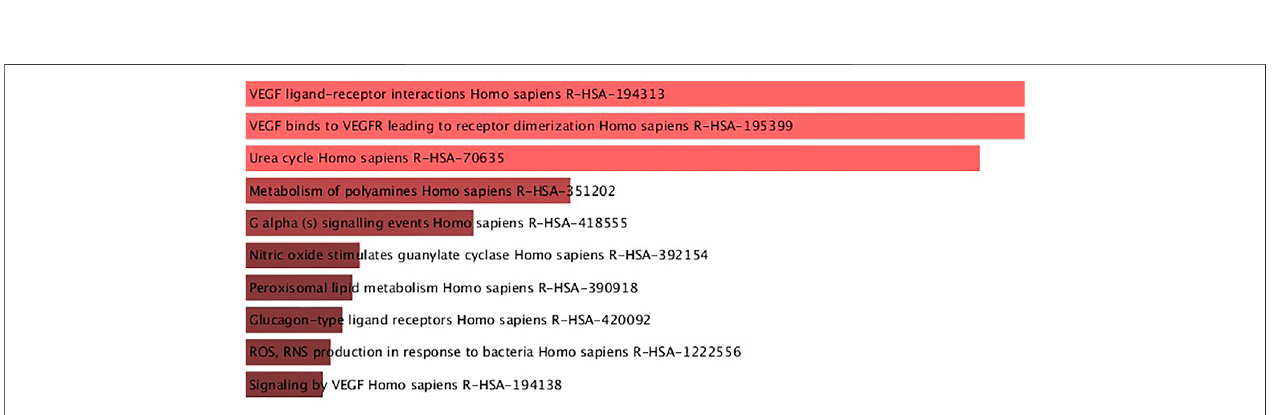
FIGURE 2 | Overlapping genes with SNPs associated with changes on HbF levels in the included studies involving patients with SCA (Hb SS) under HU therapy. BCL11A , ARG1 , and ARG2 genes showed overlap between included studies. Upset plot showing the total number of genes with SNPs found to be associated with changes on HbF levels identi fi ed in each study (horizontal bars), and the number of genes exclusive to one study or shared by different studies (vertical bars). Black dots below vertical bars indicate genes quanti fi ed.